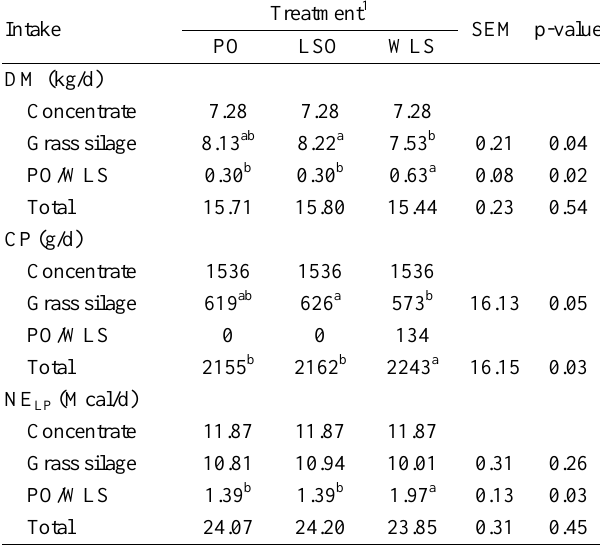
Table 3. Effects of treatment diets on DM, CP, and NE LP intakes